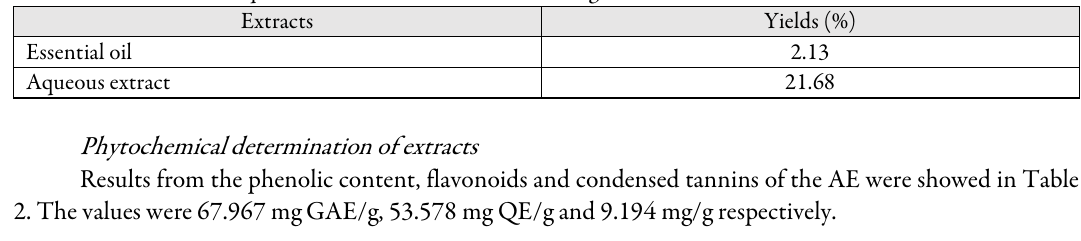
Table 2. Content of polyphenols, flavonoids and condensed tannins of the aqueous extract of